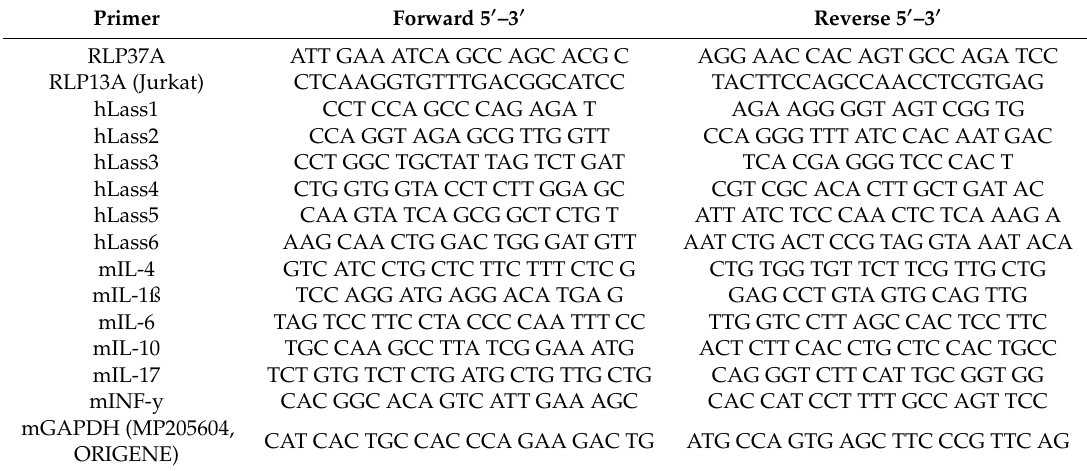
Table 1. qRT-PCR primer used for mRNA analysis. The list contains both human (h) and murine (m) primers. Human CerS iosenzymes are termed as “Lass” (longevity assurance homologue of yeast